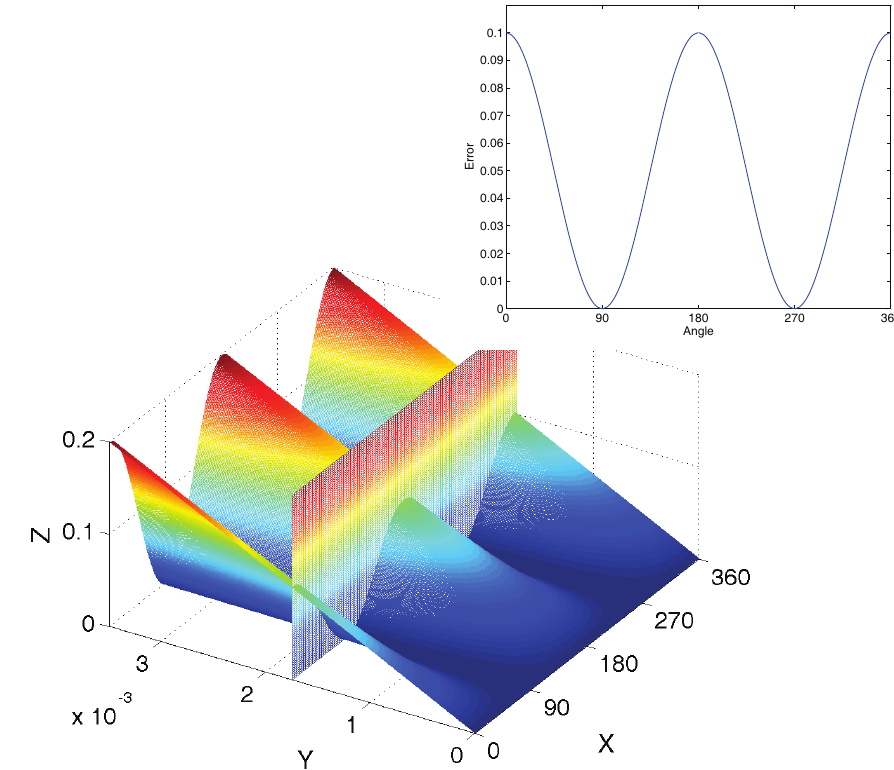
Figure 5. The error curve of phase deviation. The x -axis is the angle from 0 ◦ to 360 ◦ . The y -axis is the deviation of phase. The x -axis is the